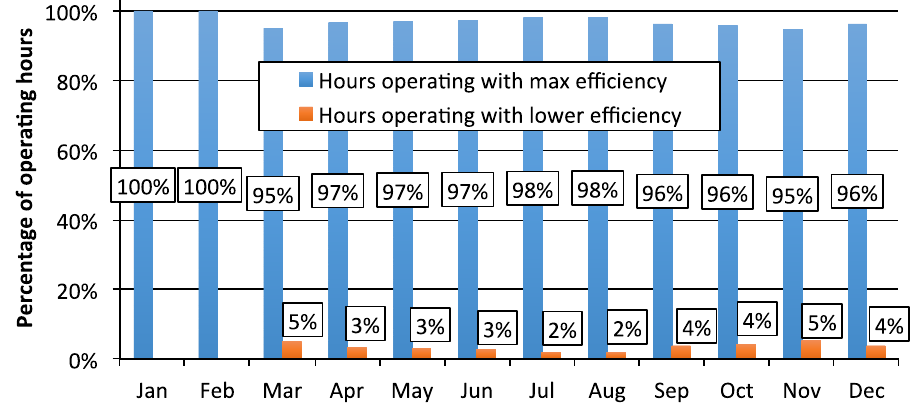
Figure 12. Percentage of diesel generators operating hours inside and outside maximum efficiency region, in the TO-BE scenario 1.